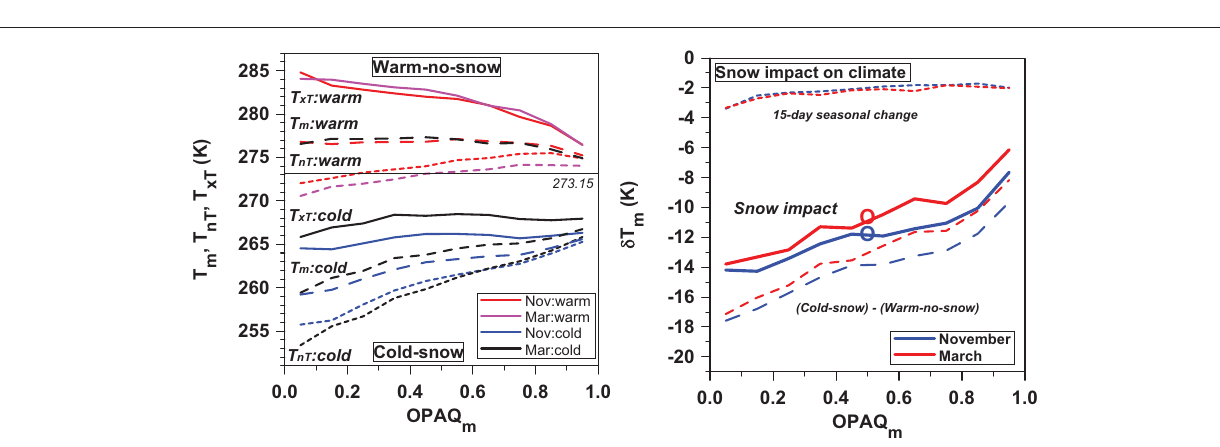
Frontiers in Earth Science |